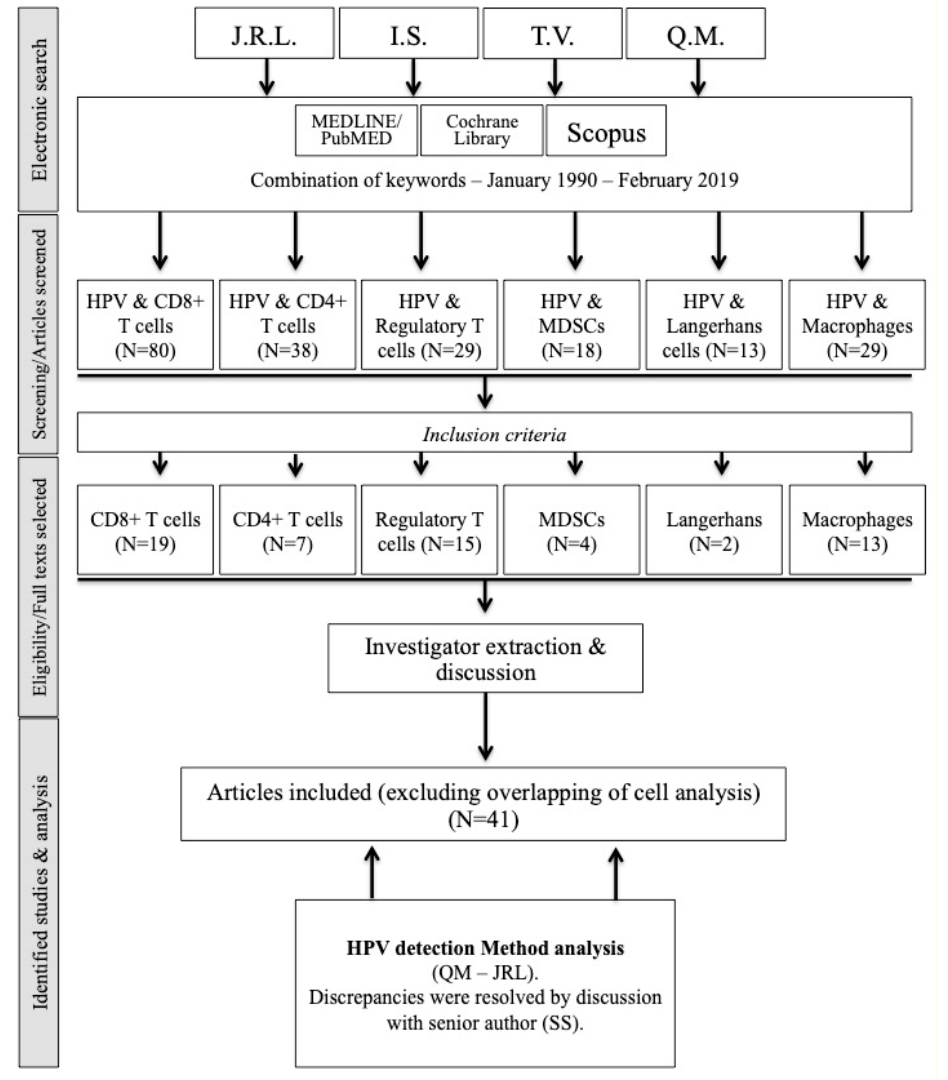
Figure 1. Flow chart. Abbreviations: HPV = human papilloma virus; MDSC = myeloid-derived suppressor cells.